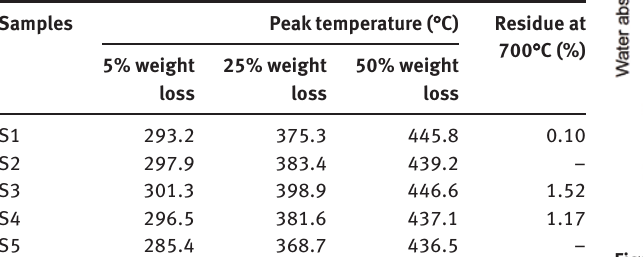
Figure 14: Water absorption (%) of the